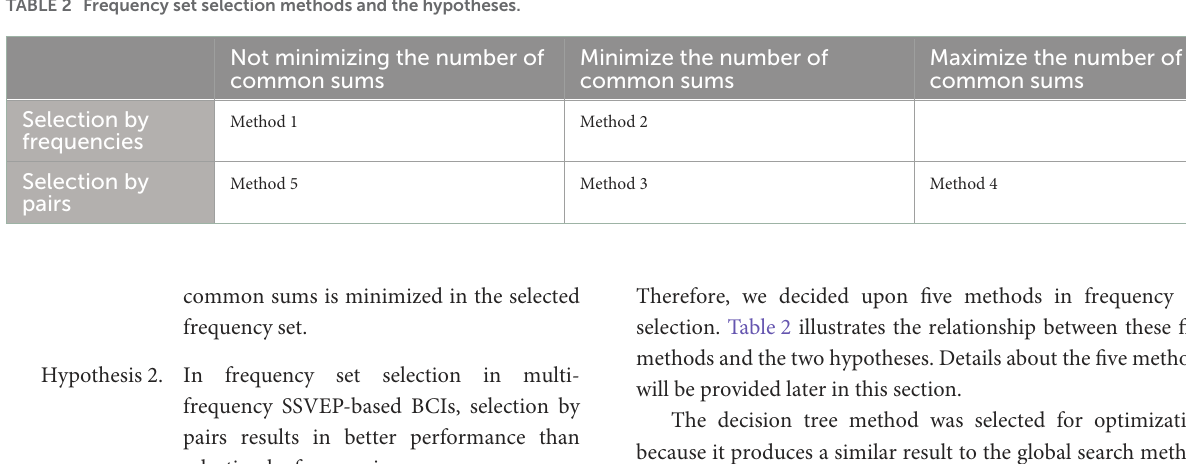
TABLE 2 Frequency set selection methods and the